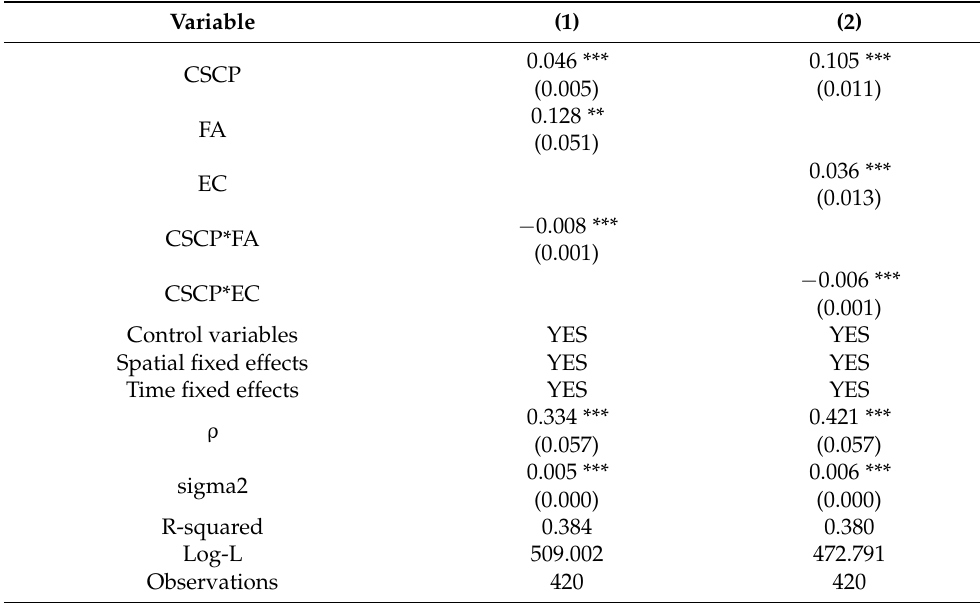
Table 5. The results of the mediating effect